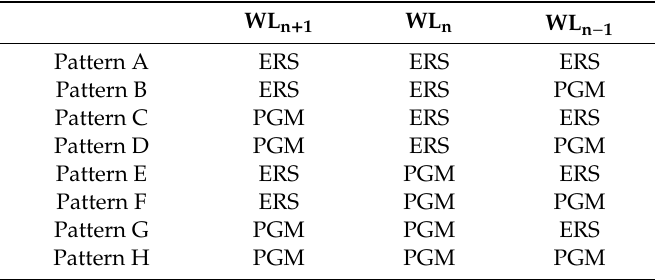
Table 1. Patterns for cell-to-cell interference.